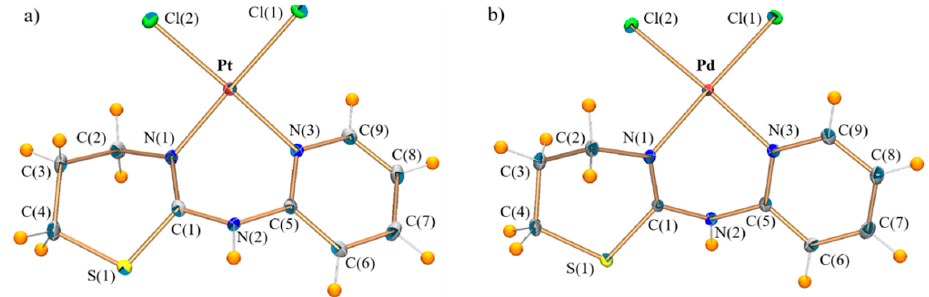
Figure 3. Crystal structures of ( a ) PtPyTz and ( b ) PdPyTz. Ethanol solvate is omitted for clarity.